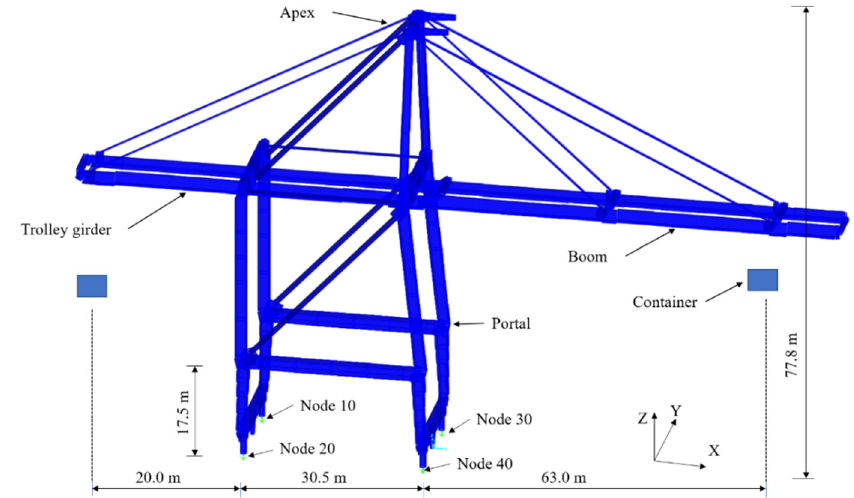
Figure 1. 3D numerical model of the Korean container crane.